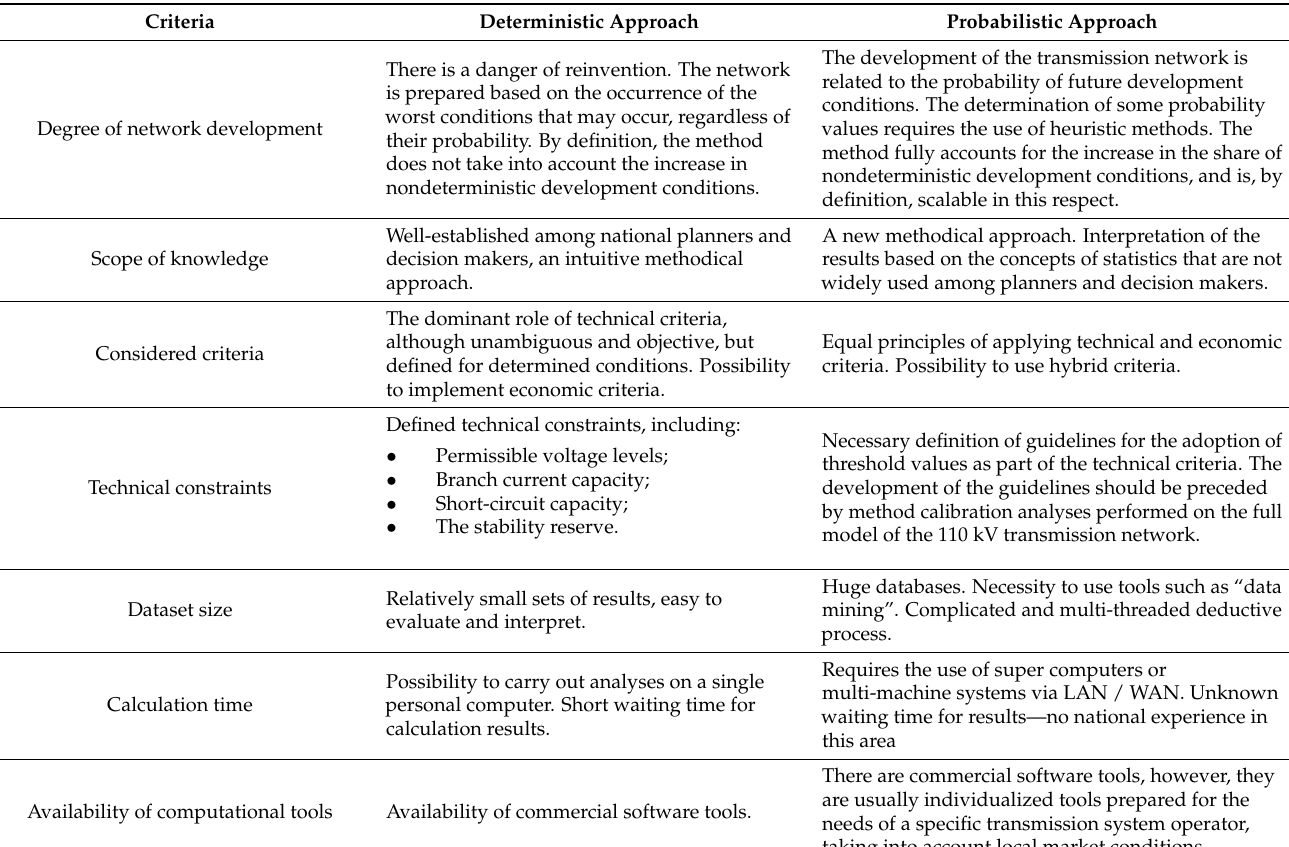
Table 3. Comparison the issues of probabilistic and deterministic